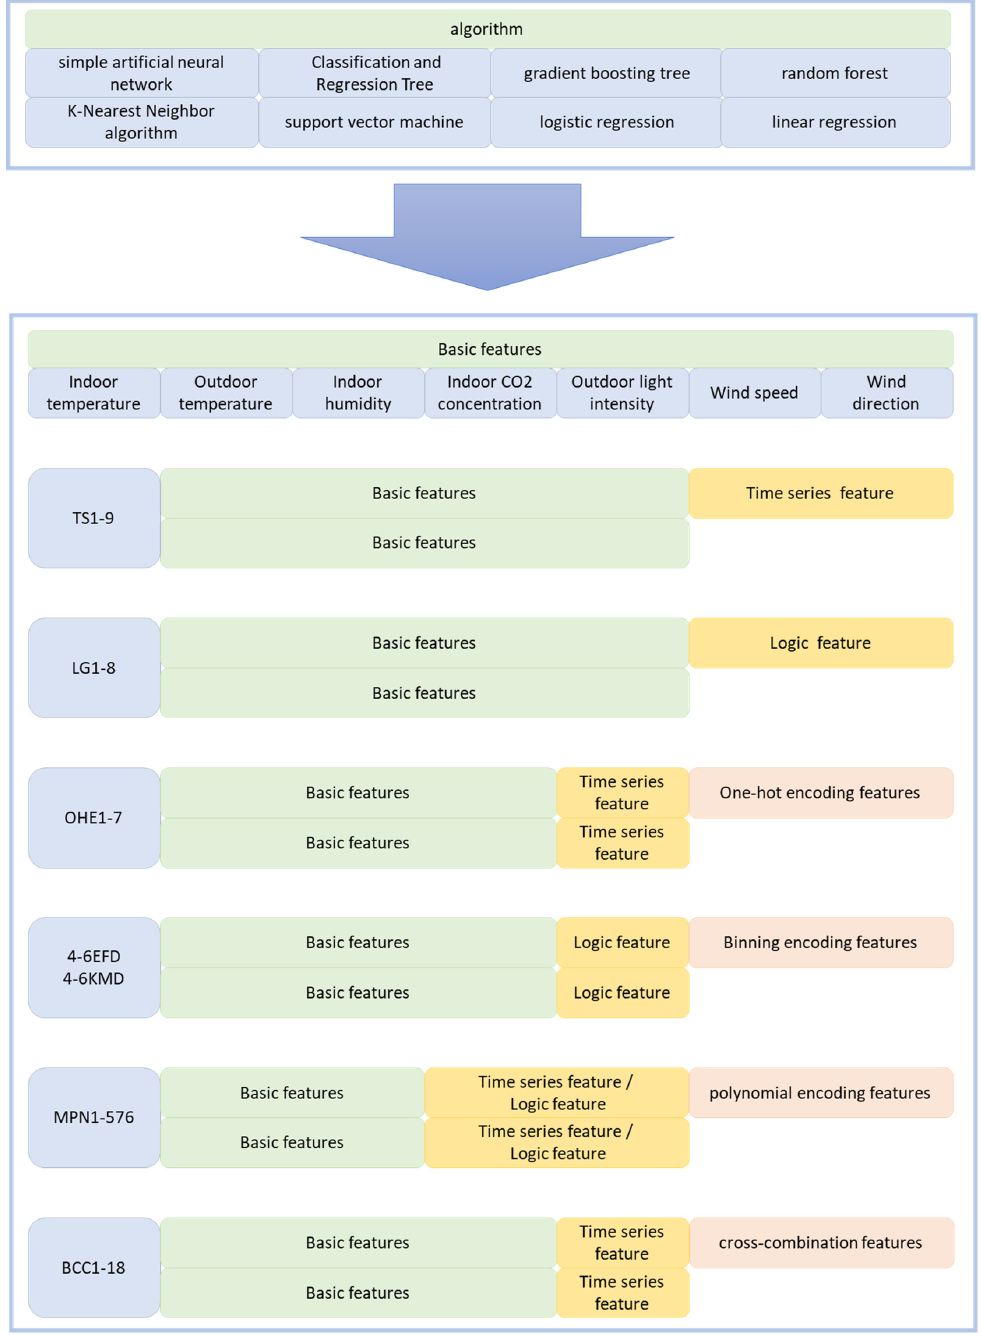
Figure 6. Experiment